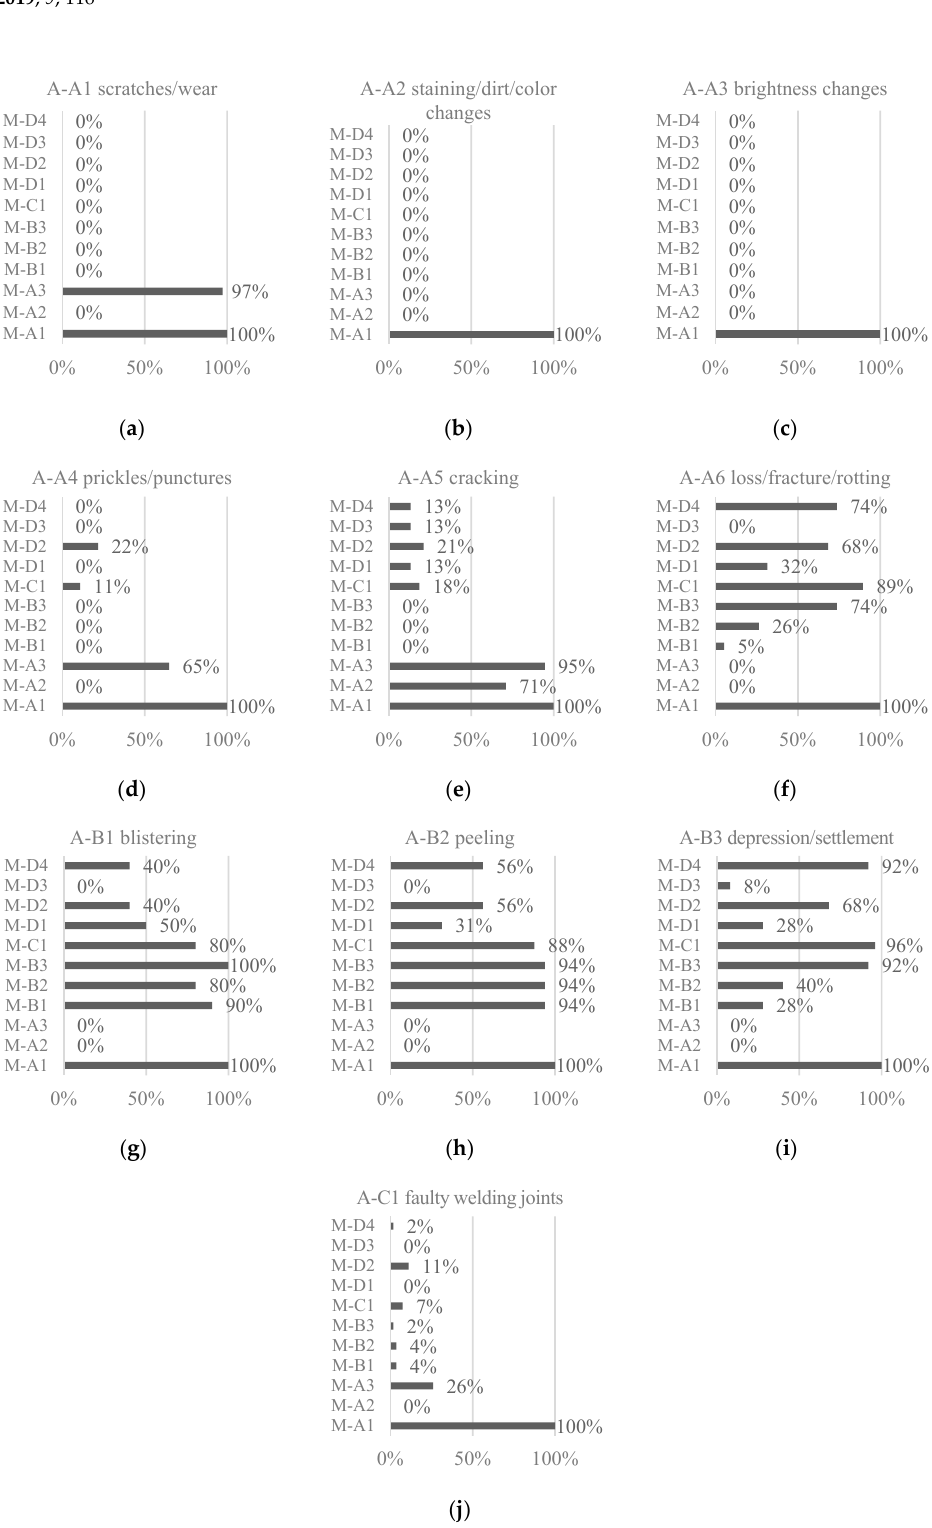
Figure 8. Contribution of each diagnosis method to each type of anomaly in the sample: ( a ) A-A1 scratches/wear; ( b ) A-A2 staining/dirt/color changes; ( c ) A-A3 brightness changes; ( d ) A-A4 prickles/punctures; ( e ) A-A5 cracking; ( f ) A-A6 loss/fracture/rotting; ( g ) A-B1 blistering; ( h ) A-B2 peeling; ( i ) A-B3 depression/settlement; ( j ) A-C1 faulty welding joints.